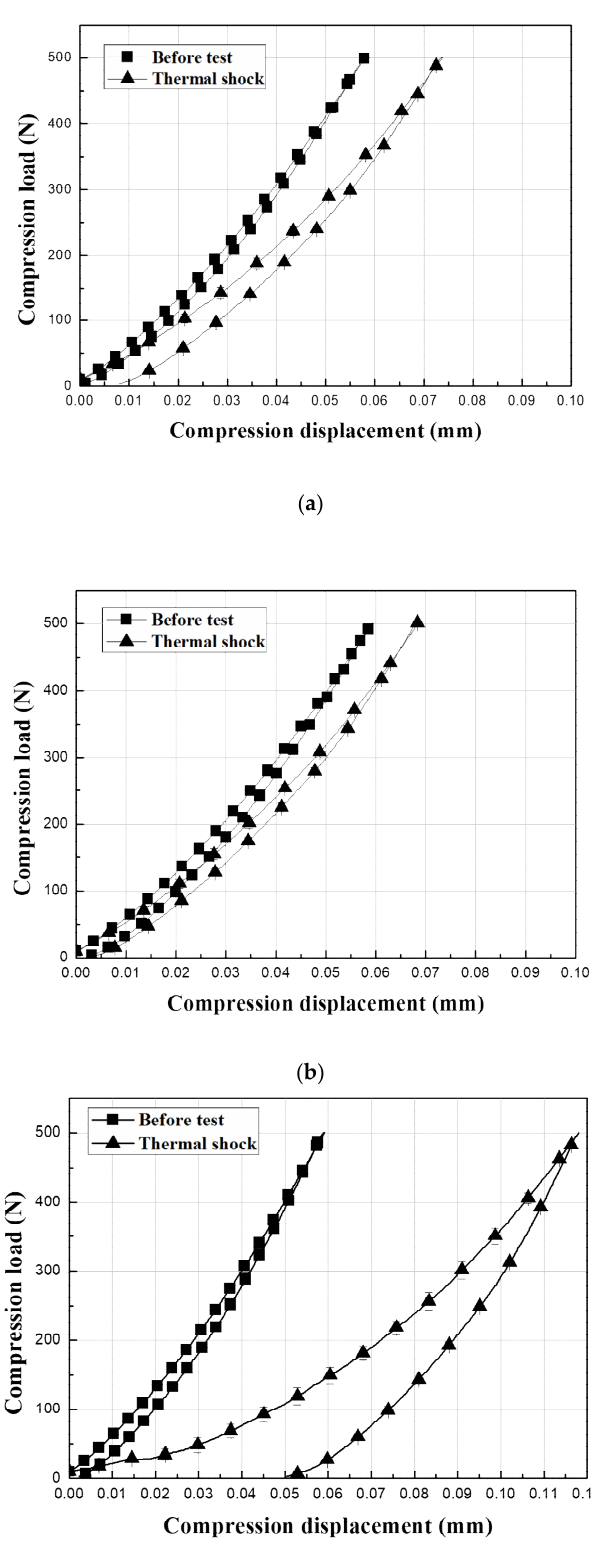
Figure 10. Plot of indentation load–displacement curves of ( a ) mullite, ( b ) mullite + Yb 2 SiO 5 and ( c ) Y 2 SiO 5 using a WC ball with a radius of 3.18 mm at load P = 500 N.